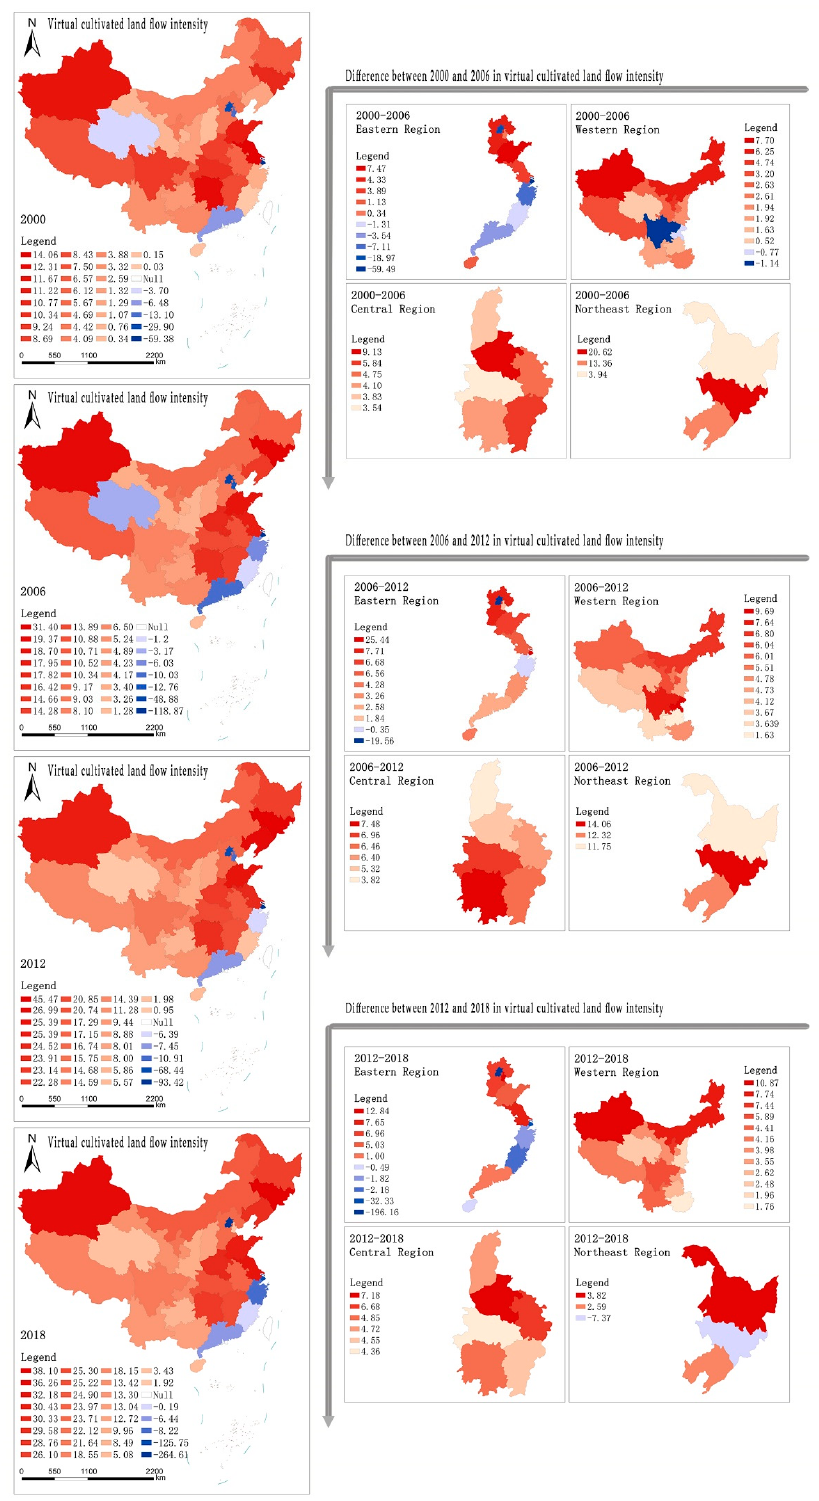
Figure 2. The distribution pattern of virtual cultivated land flow intensity in mainland China (Notes: The figure on the left shows the virtual cultivated land flow intensity in 31 provinces of China from 2000 to 2018, with red representing the surplus area and blue representing deficit area, and the intensity of surplus/deficit expressed by color concentration, that is, the darker the color, the greater the intensity; the right figure is a regional diagram of the difference of virtual cultivated land flow intensity in different periods, and the red and blue are used to distinguish increase and decrease. Similarly, the degree of increase/decrease is expressed by color